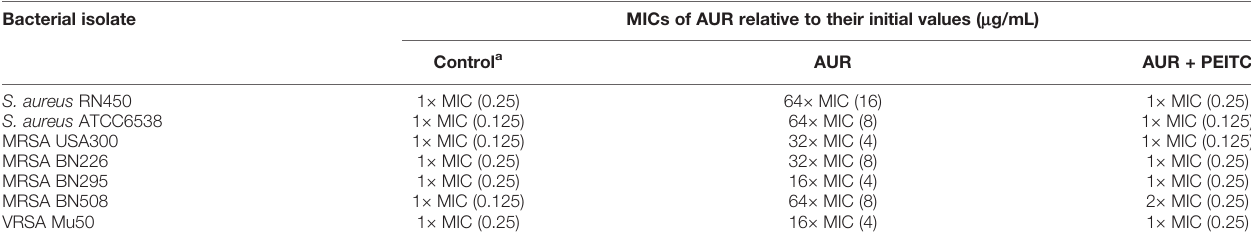
The values of AUR MICs are shown in brackets. a Controls, no treatment. AUR, aurano fi n; PEITC, phenethyl isothiocyanate. Data are from at least three independent